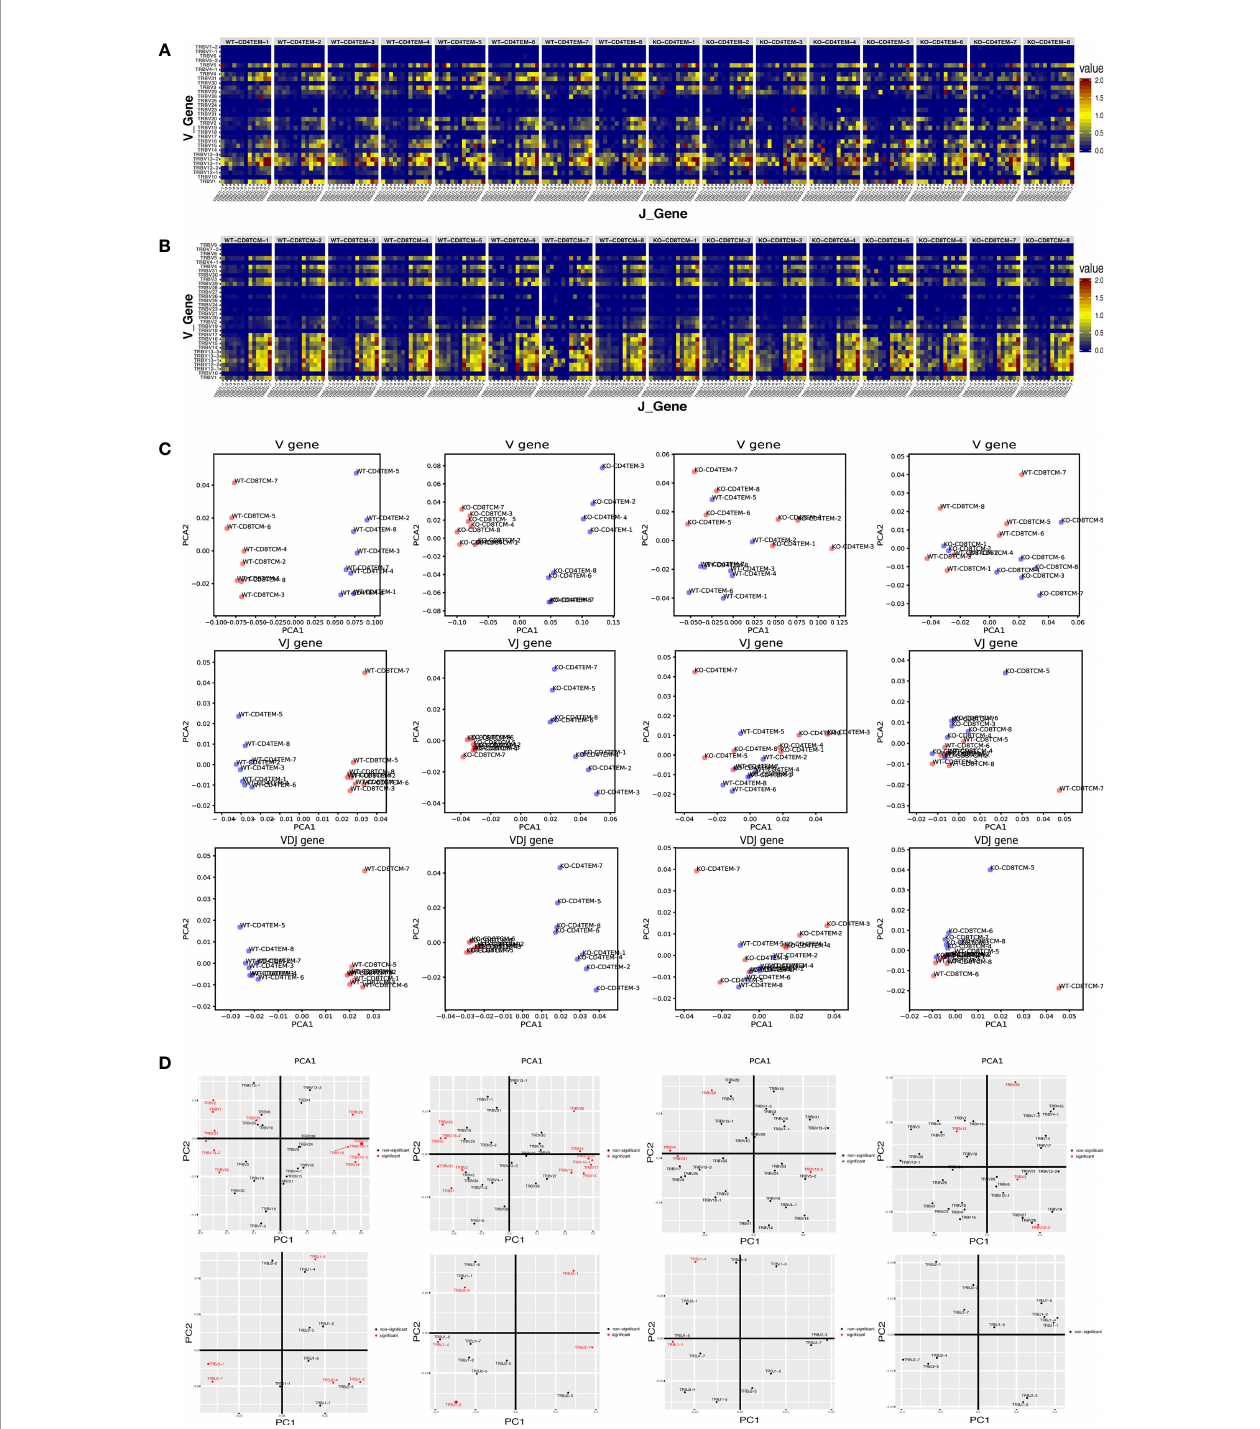
FIGURE 3 | Differential V – J and V – D – J combination of CD4 + TEM cells and CD8 + TCM cells in WT and KO chimeras. Heatmap representing the frequency of V – J combination for CD4 + TEM cells (A) and CD8 + TCM cells (B) in WT and KO chimeras. Sample plots illustrating the segregation of CD4 + TEM cells from CD8 + TCM cells in WT chimeras, CD4 + TEM cells from CD8 + TCM cells in KO chimeras, KO from WT chimeras in CD4 + TEM cells, and that of KO from WT chimeras in CD8 + TCM cells (from left to right) based on PCA of V genes, the combination of V – J and also V – D – J, distribution of V gene families and J gene families (from up to down) (C) . V and J gene families with signi fi cant differences were shown in red (D) (p <